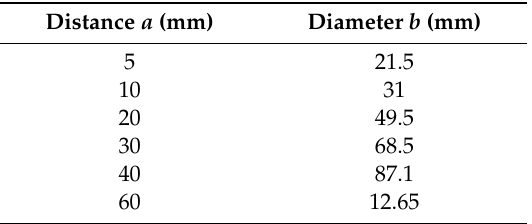
Table 1. Light spot divergence angle test records.